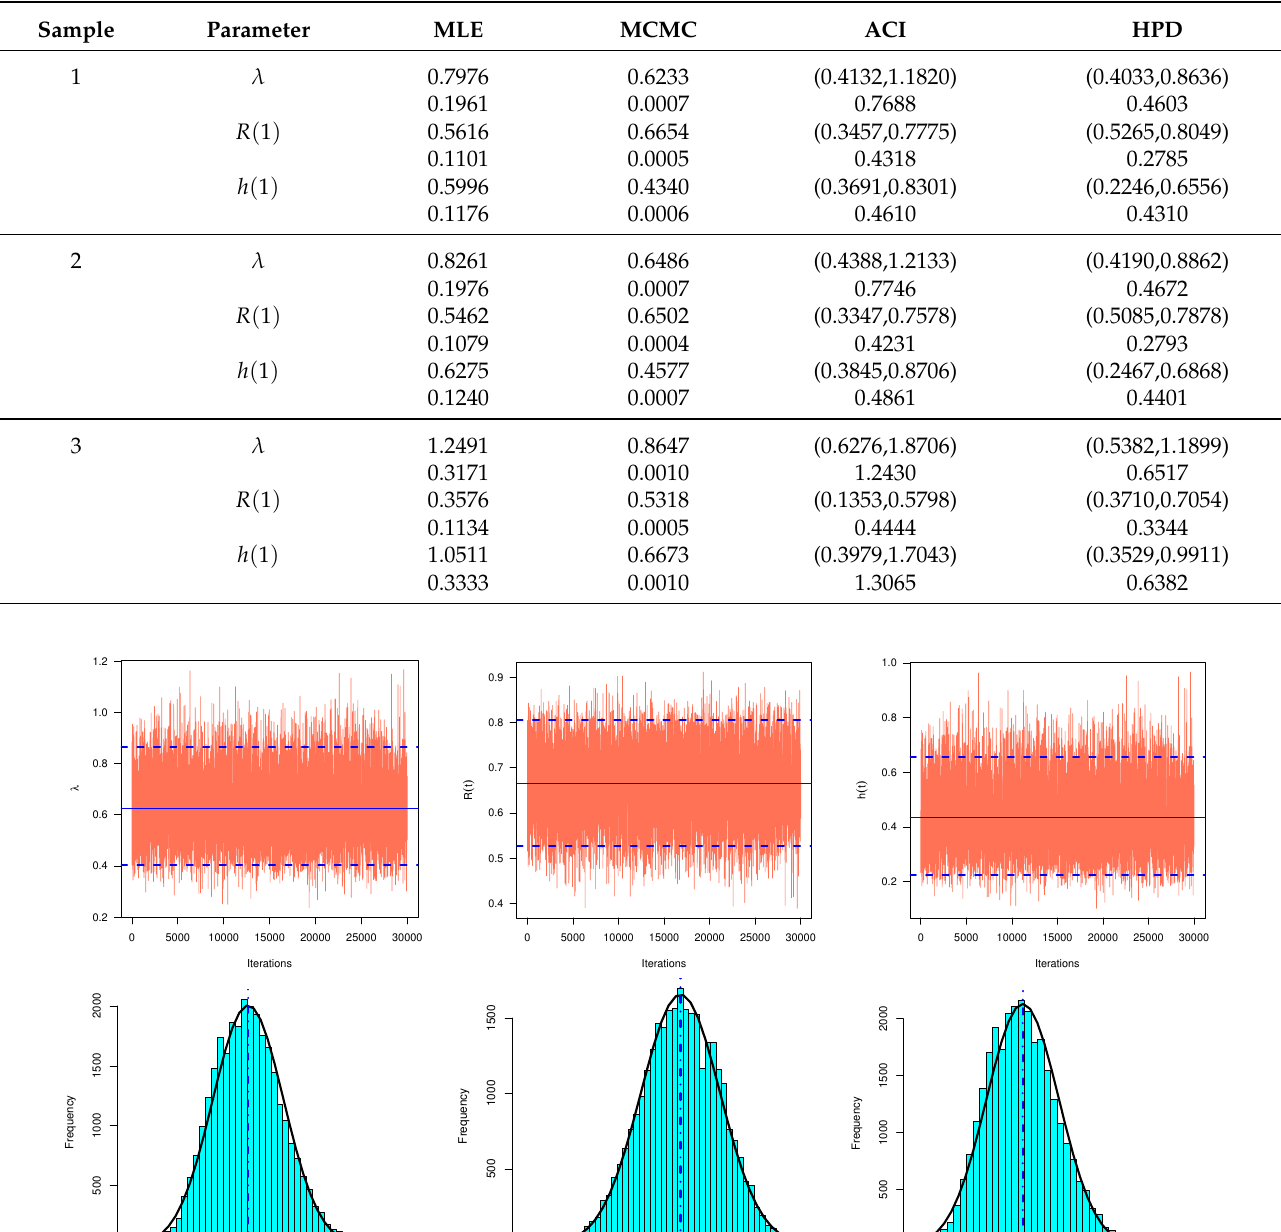
Table 3. The point and interval estimates of λ , R ( t ) , and h ( t ) from SSB data.